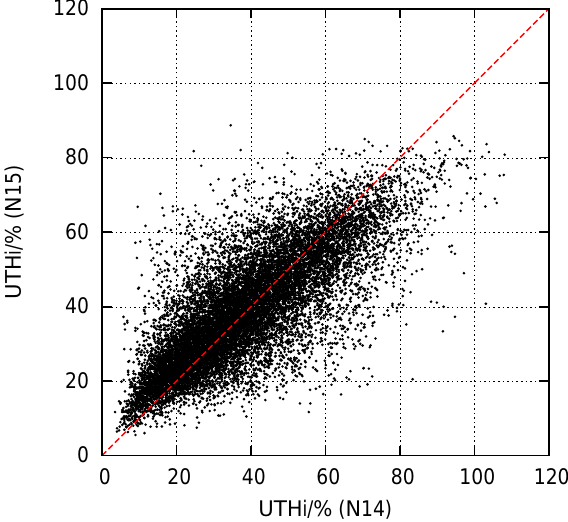
Figure 3. As Fig. 1, but with UTHi retrieved from modified chan- nel 12 brightness temperatures for HIRS 3 on NOAA 15, according to Eq. (3). While the data points no longer have an excess above the (red dashed) diagonal, another problem appears: the range of UTHi retrieved from N15 data is drastically reduced to values slightly ex- ceeding 90% – that is, instead of reducing the number of supersat- uration cases, they have been eliminated, an undesired effect.